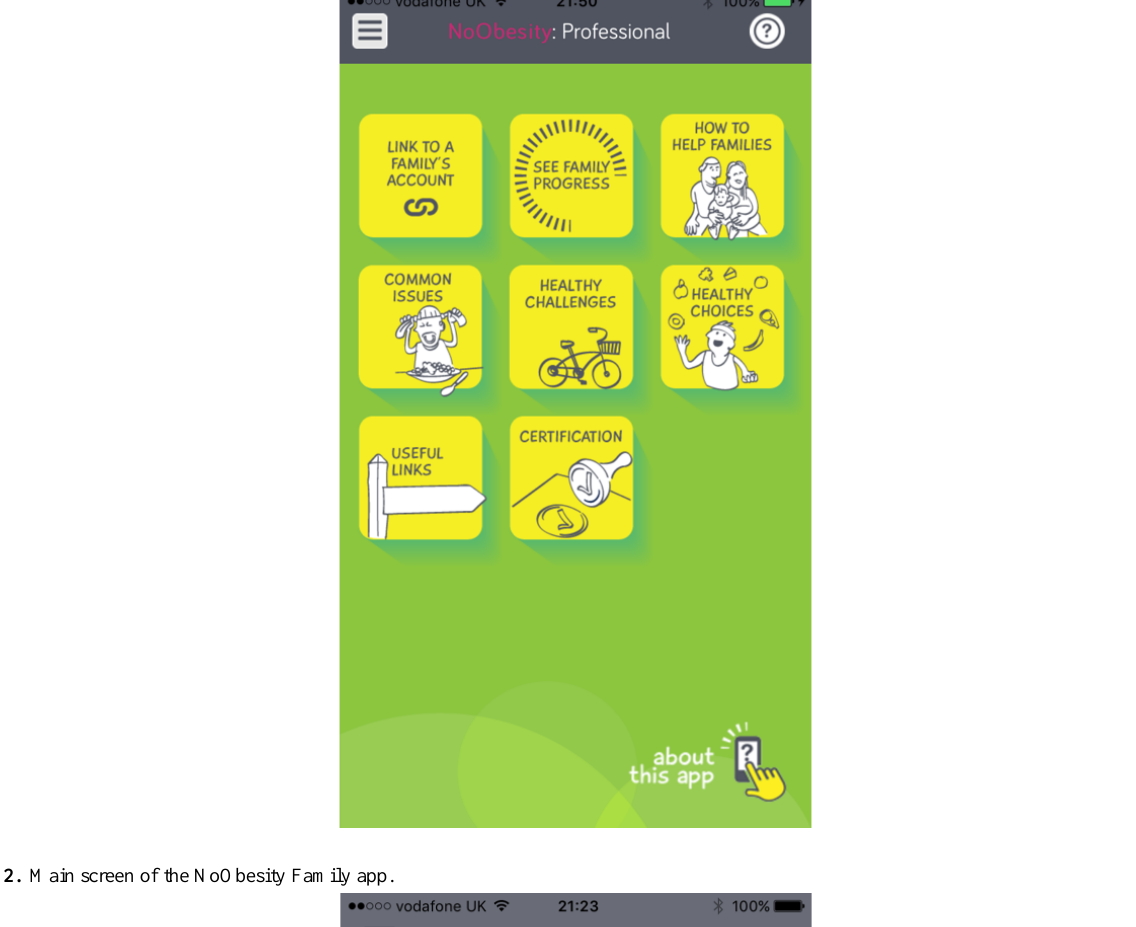
Figure 2. Main screen of the NoObesity Family